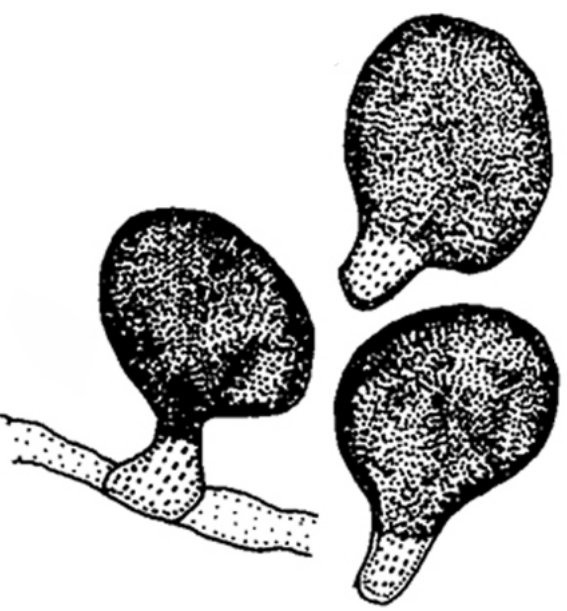
Figure 198. Acremoniula sarcinellae -Black